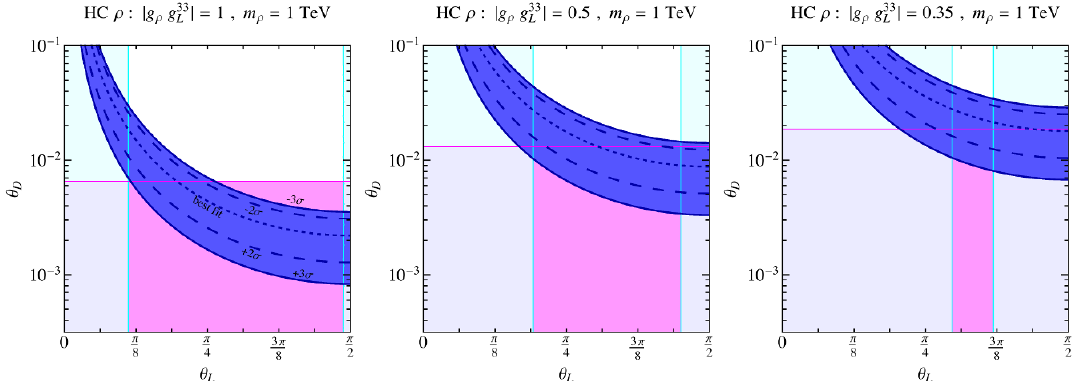
j with m (cid:26) = 1 TeV L